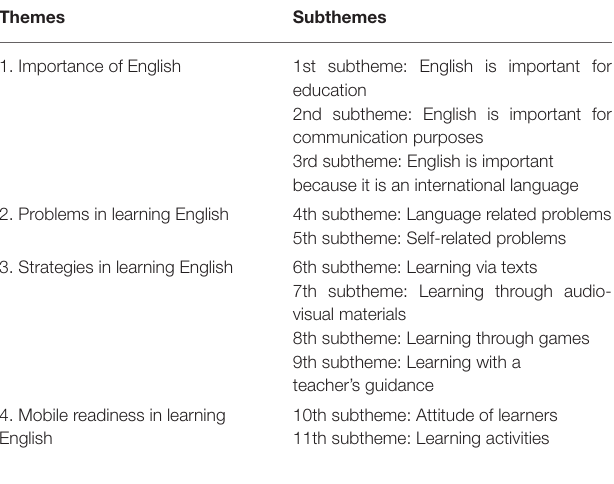
TABLE 1 | Summary of the main themes and